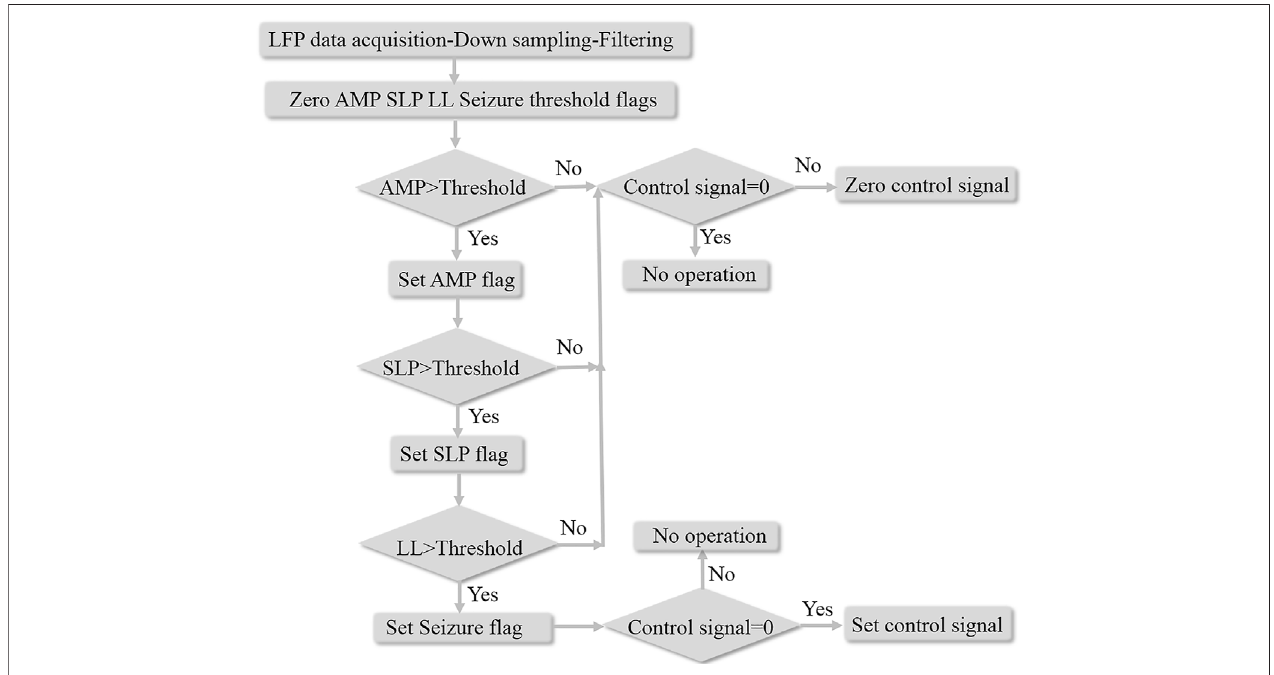
FIGURE 2 | Flow chart of the seizure detection